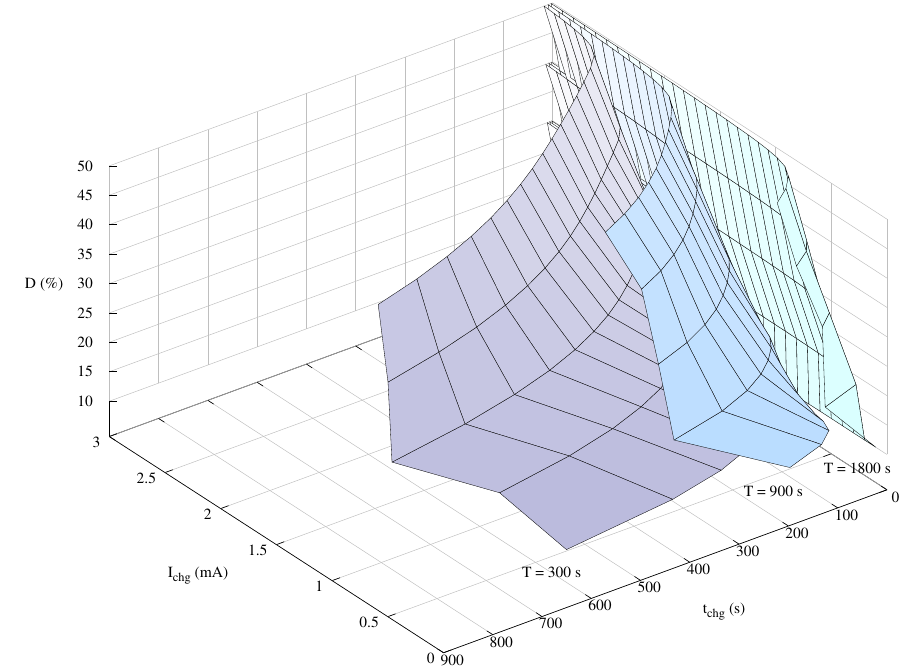
Figure 13. Optimal design space curves for different iteration